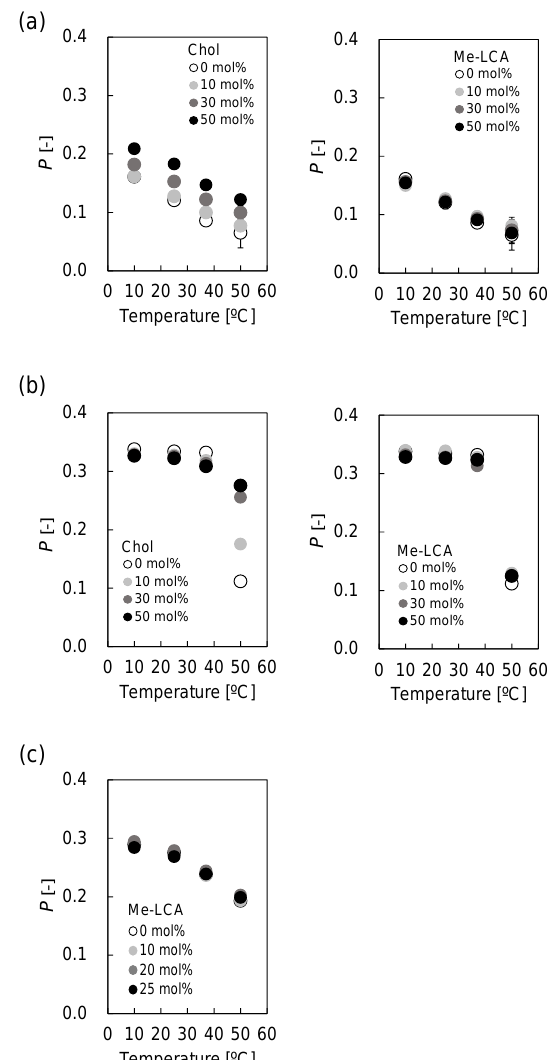
Figure 4. p values of ( a ) DOPC liposome, ( b ) DPPC liposome, and ( c ) DOPC/DPPC/Chol (1:1:1, mol/mol) liposome with Me-LCA.